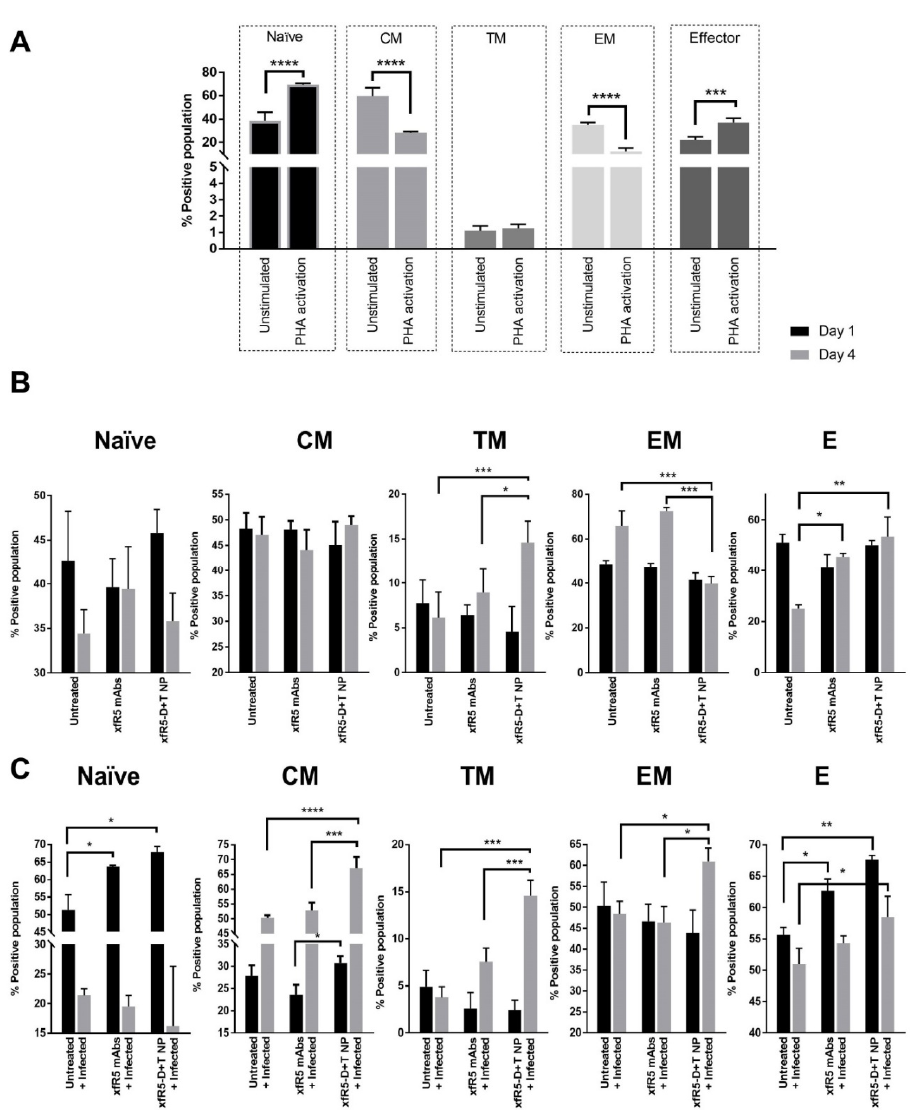
Figure 3. T-cell differentiation phenotype under ( A ) untreated, ( B ) protection against HIV challenge (HIV prophylaxis), and ( C ), HIV infected T-cell treatment (HIV treatment) condition. ( A ) The im- munophenotypic differentiation (after day 1 and day 4) of untreated-nonactivated PBMCs was com- pared with PHA-activated PBMCs. ( B ) Immunophenotyping pattern evaluation after cell treatment followed by HIV challenge condition. The immunophenotypic differentiation of untreated PBMCs was compared to xfR5 mAbs, and xfR5 D+T NPs were compared on day 1 (after 1 day of treatment) vs. day 4 (after HIV-1 ADA virus challenge). ( C ) Immunophenotyping pattern eval- uation of HIV infected followed by treatment condition. The immunophenotypic differentiation of untreated+infected PBMCs was compared to infected PBMCs treated with xfR5 mAbs, or xfR5 D+T NPs were compared on day 1 vs. 4, after 1 day of treatment. The differentiation pattern was evaluated following naïve, CM, TM, EM, and E sub-population as depicted in the x-axis, whereas the y-axis represents respective marker% positive cells. The data are presented as mean ± SEM of three independent experiments on three healthy donors ( n = 3). The significance was represented by the asterisk (*) symbol, where ‘*’, ‘**’, ‘***’ and ‘****’ correspond to p values <0.05, <0.01, <0.001 and <0.0001,